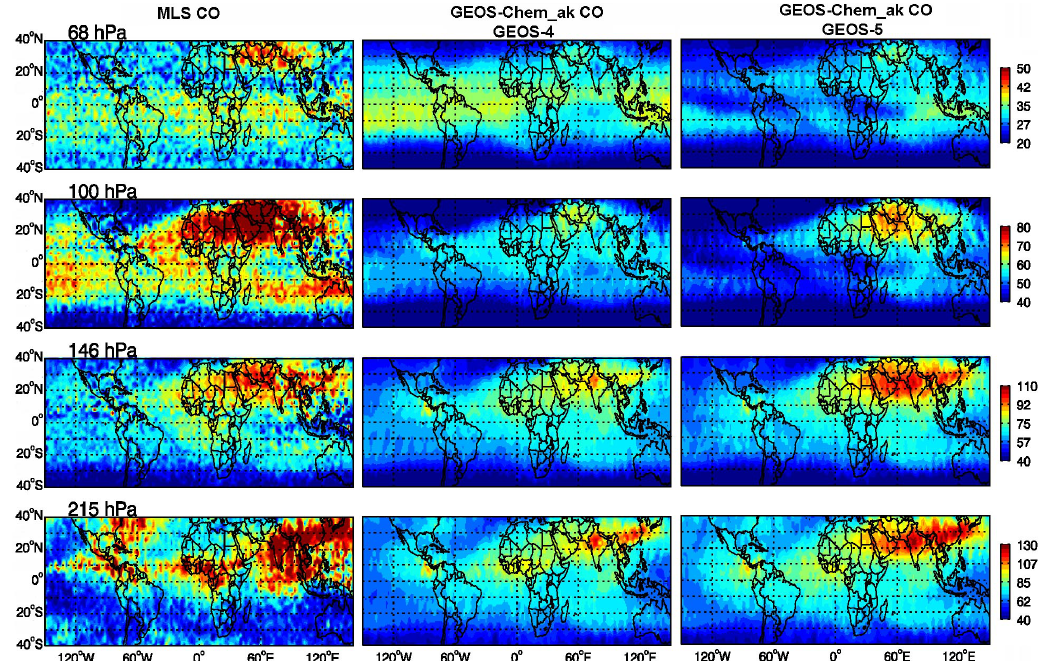
Fig. 5. Spatial patterns of monthly mean CO mixing ratios at 215hPa, 147hPa, 100hPa and 68hPa for July 2005 during the Asian monsoon season from MLS (left), the GEOS-Chem simulations driven by GEOS-4 (middle) and GEOS-5 (right) using GFED2 emissions with the MLS AKs